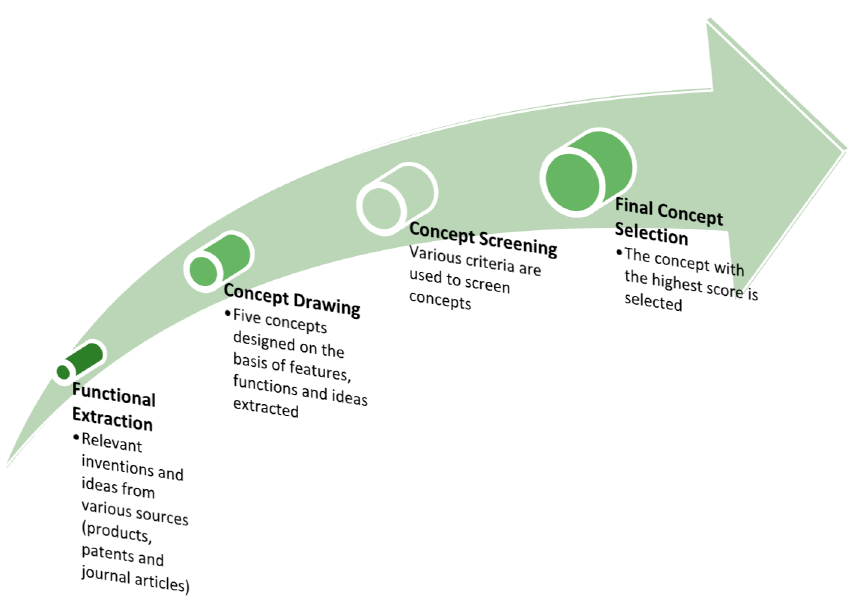
Figure 1. Conceptualisation technique.